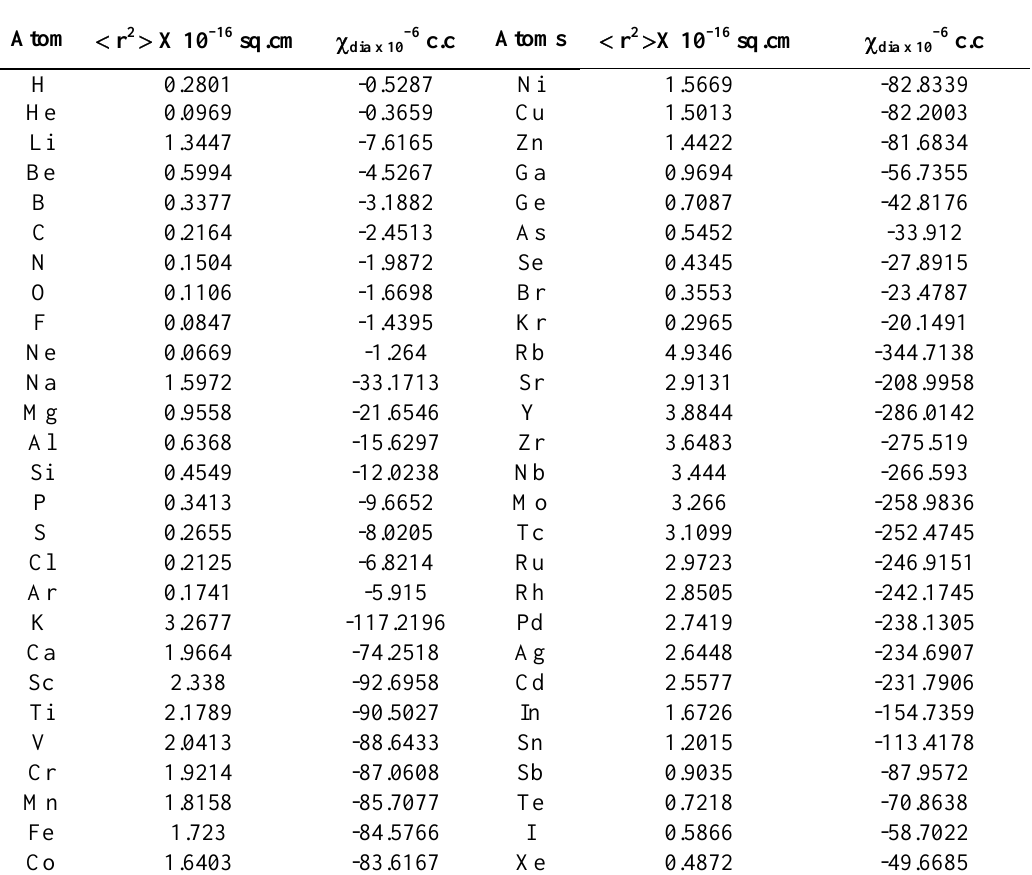
Table 2. Computed mean square radii, < r 2 > and diamagnetic part of atomic susceptibility, ( χ ) of dia